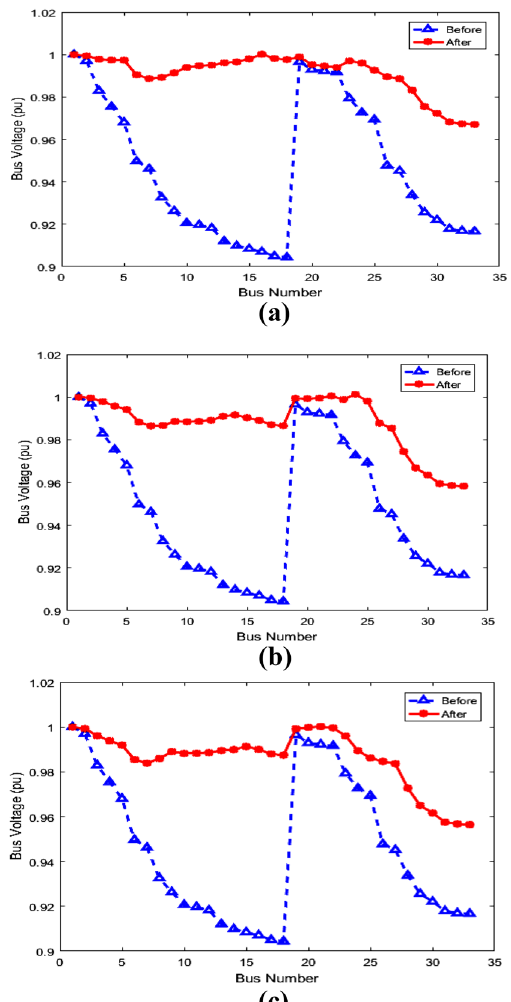
Fig. 7 The graph of voltage Profiles in the 33-bus network, a unit resulting, b 0.85 Post-phase, c 0.85